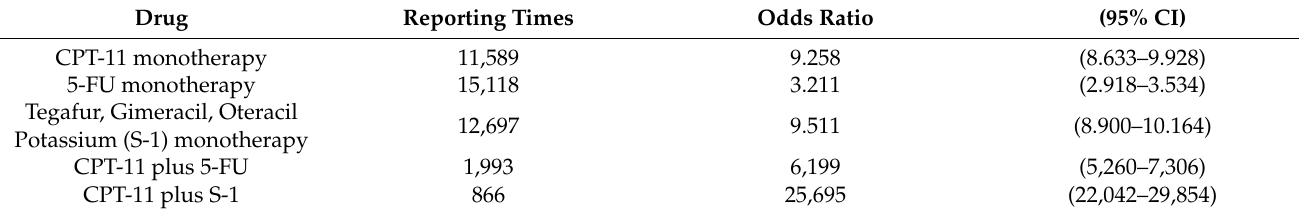
Table 2. Reporting odds ratio of diarrhea associated with irinotecan (CPT-11)-containing chemotherapy regimens. Drug CPT-11 monotherapy